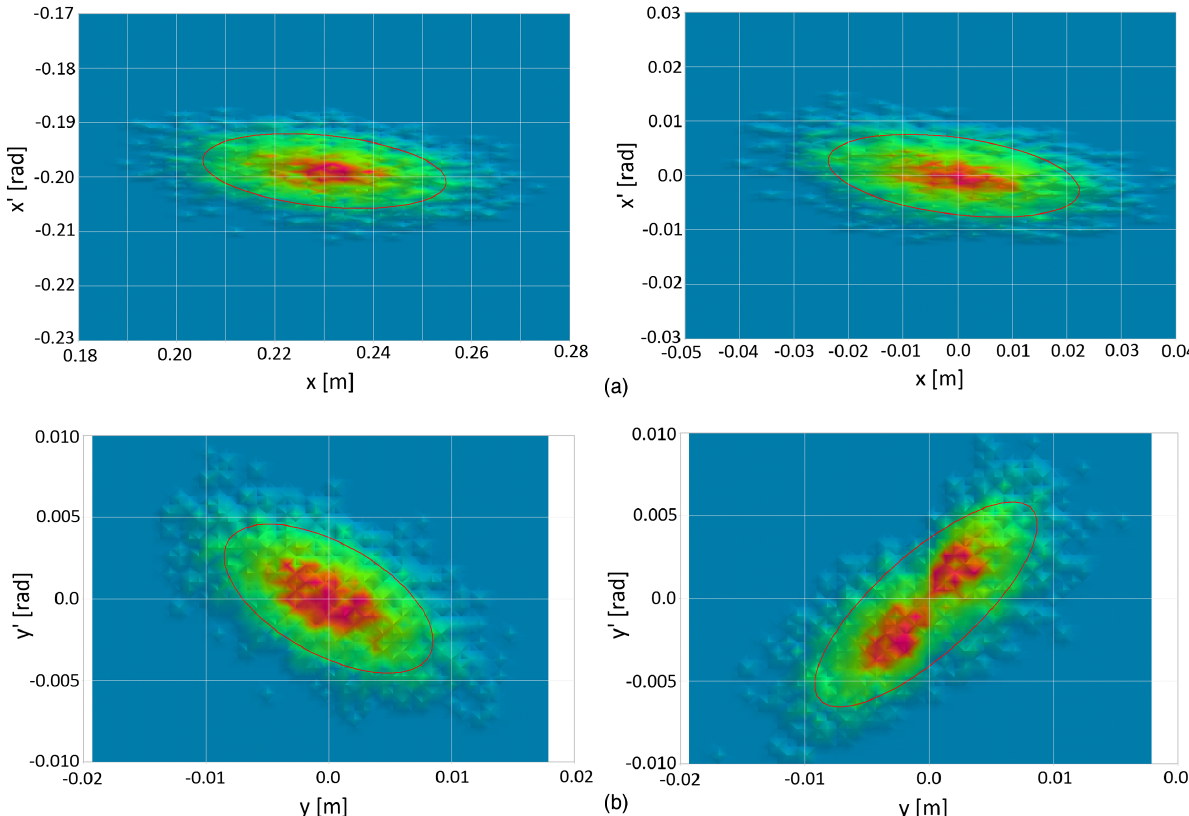
FIG. 18. (a) Beam distribution in the horizontal phase space. Here, the initial and final beam distributions are shown in the left and right figures, respectively. The solid red line is the Courant-Snyder ellipse with 2 (cid:2) emittance. (b) Beam distribution in the vertical phase space. Here, the initial and final beam distributions are shown in the left and right figures, respectively. The solid red line is the Courant-Snyder ellipse with 2 (cid:2) emittance. Figures 20(b) and 20(c) show the final beam distributions in the horizontal and vertical phase spaces, respectively.